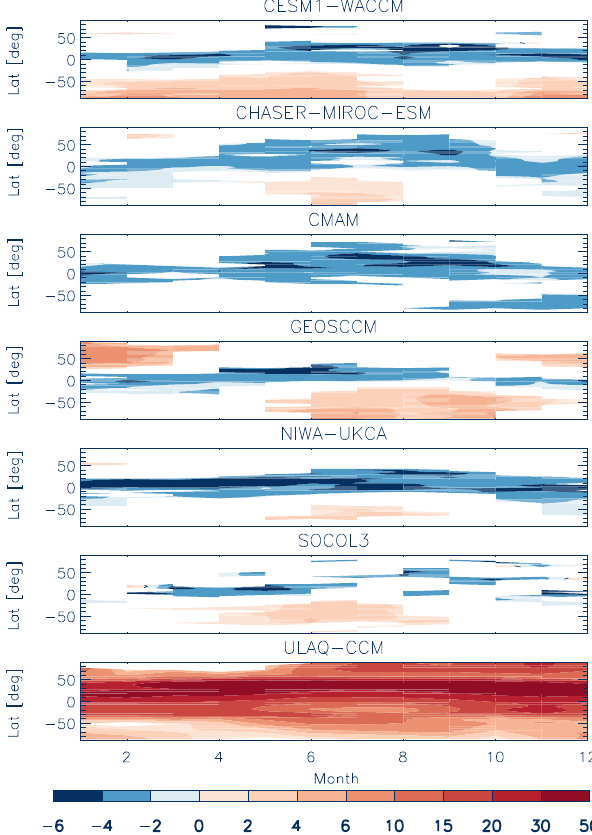
Figure 6. Same as Fig. 3 but for N 2 O, in ppbvppmv − 1 , as derived from the REF-C2 and SEN-C2-fN2O